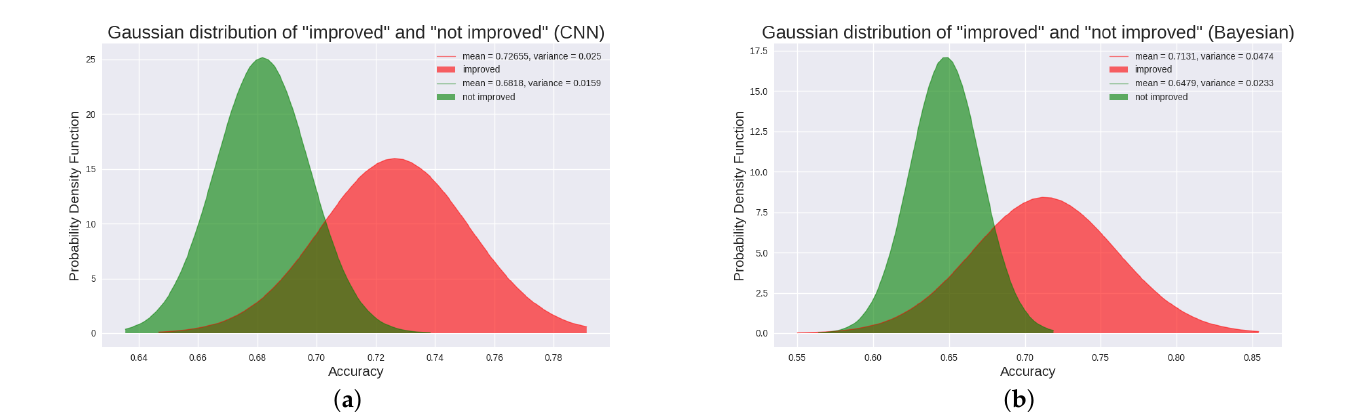
Figure 4. Panel ( a ) depicts the Gaussian distribution between “improved” patients and “not improved” patients using the CNN method. Panel ( b ) depicts the Gaussian distribution between “improved” patients and “not improved” patients using the Bayesian method. The probability distribution of “improved” patients and “not improved” patients. The red one is the Gaussian distribution fitted to the P300 detection accuracy of the “improved” patients, and the green one is the Gaussian distribution fitted to the P300 detection accuracy of the “not improved” patients. From the figure, we can see that there is a significant difference in the P300 detection accuracy of the two types of patients, and the P300 detection accuracy of the “improved” patients is significantly higher than that of the “not improved”